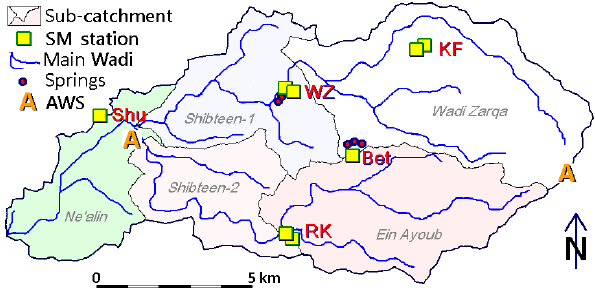
Figure 4. Drainage and measurement stations. Main branches of the northern and southern branches of Wadi Natuf. Soil moisture (SM) stations at Shuqbah (Shu), Wadi Zarqa (WZ), Beitillu (Bet), Kufr Fidiah (KF) and Ras Karkar (RK). Daily measured springs at Beitillu and Wadi Zarqa. Automatic weather stations (AWSs) at Shibteen (west) and Birzeit (east). Sub-catchments (in grey) at Ne’alin (west), Shibteen-1 (midstream; north), Shibteen-2 (mid- stream; south), Ein Ayoub (southeast) and Wadi Zarqa